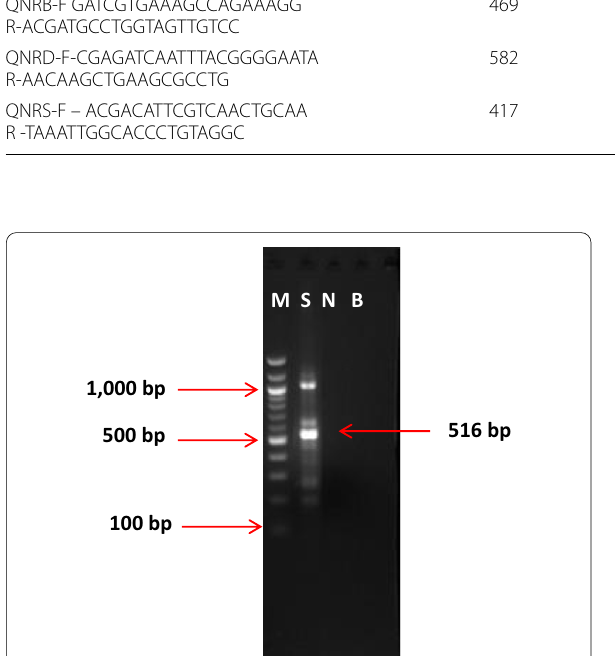
Fig. 1 Analyses of the QNR primers for Plasmid-mediated Quinolone Resistance genes in E. coli samples. M-100 bp molecular marker; S— E. coli from Budgerigar bird , N—Negative control, B—Buffer control. Sample amplified QNRA at 516 bp and negative for QNRB at 469 bp, QNRD at 582 bp and QNRS at 417